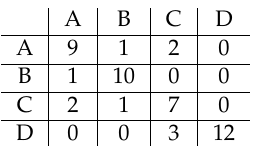
Table 1. Confusion matrix of genotypes A, B, C &